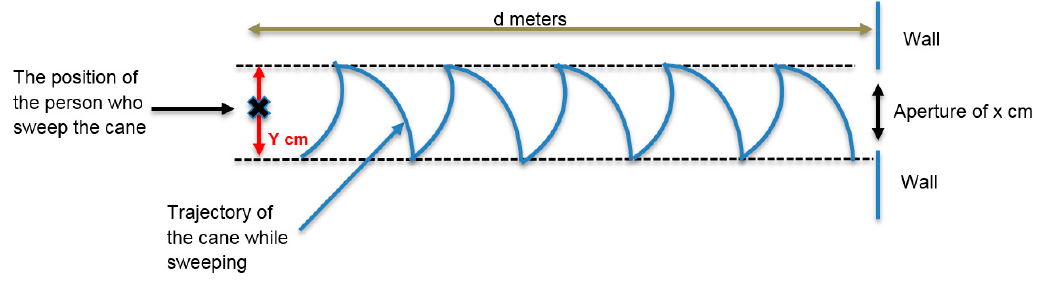
Figure 2. A descriptive illustration of the movement of the tip of the cane while walking.